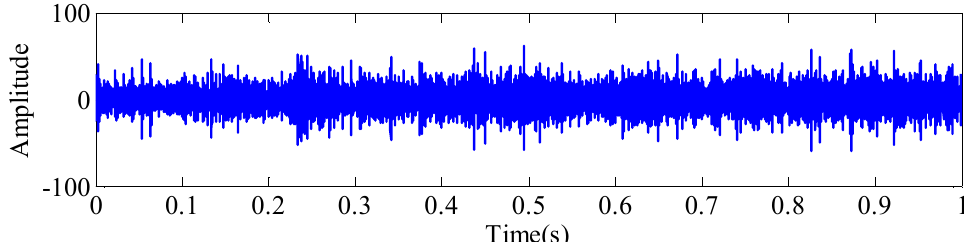
15 of 18 Figure 21. Noise reduction diagram of the randomly selected signal segment. Figure 22. The envelope spectrum map of the randomly selected signal segments. Next, through visual observation of the vibration form of the signal, a segment of the